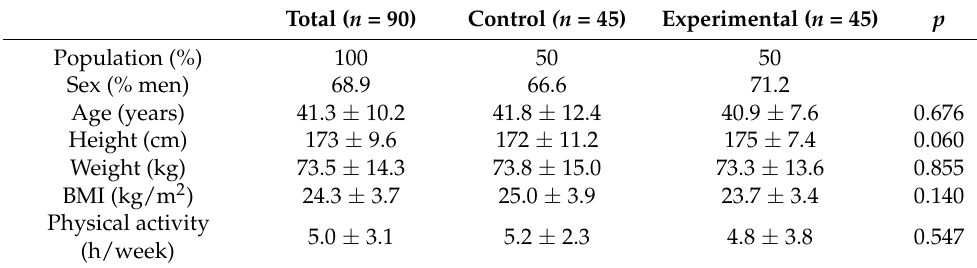
Table 1. Characteristics of the studied population.